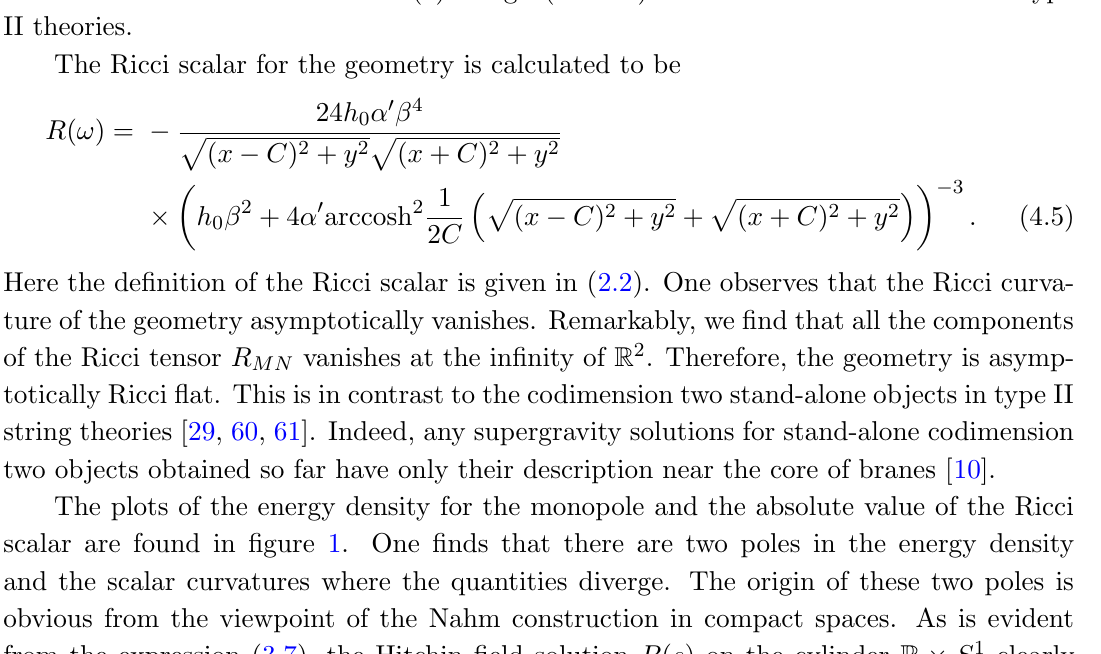
Figure 1 . The energy (topological charge) density 1 ( x 1 ; x 2 ) plane (left). The parameters are C = 1, (cid:12) = 1. The absolute value of the Ricci scalar in the ( x 1 ; x 2 ) plane